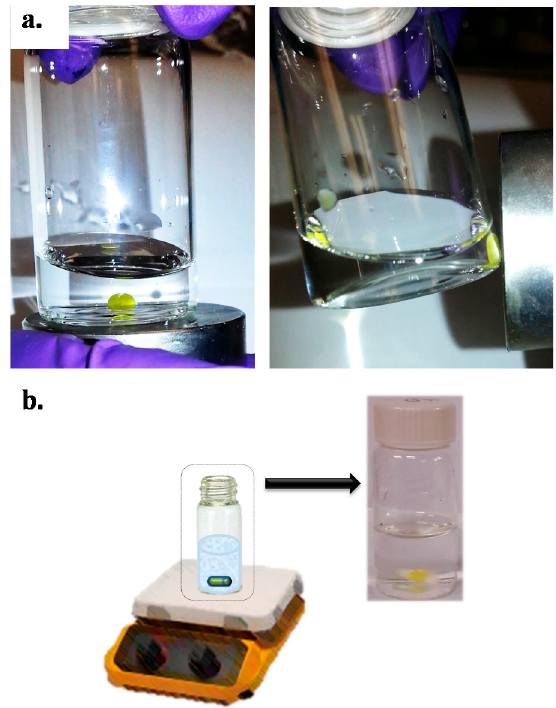
Figure 1. ( a ) Effect of an external magnetic field on the magnetic ionic liquid (MIL), and ( b ) sche- matic representation of final microextraction setup. The MIL (yellow) remained attached to the magnetic stir bar during extraction time.